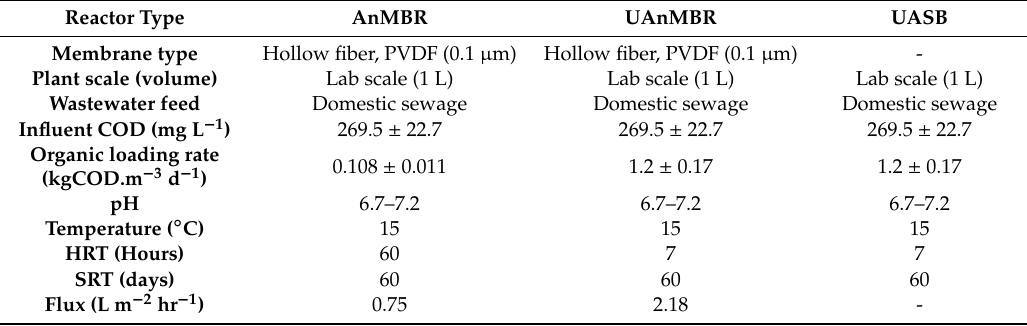
Table 1. Operational parameters of upflow anaerobic membrane bioreactor (UAnMBR), membrane bioreactor AnMBR, and upflow anaerobic sludge blanket (UASB)